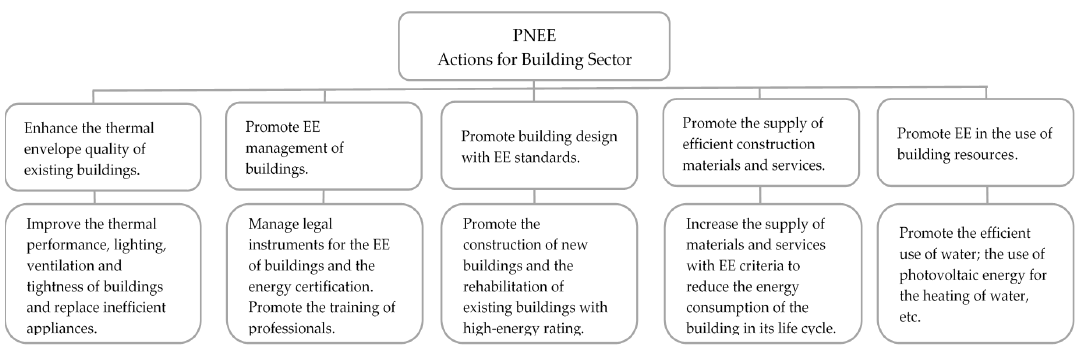
Figure 6. Actions for the Building Sector according to PNEE [38].